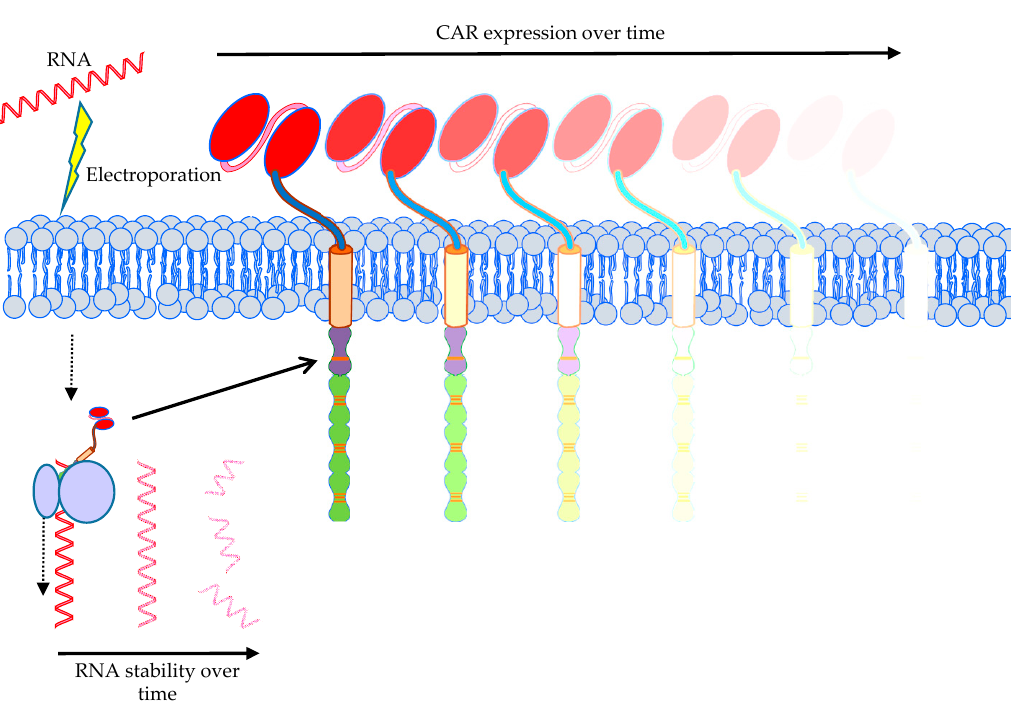
Figure 11. Schematic representation of introduction of a CAR by mRNA electroporation. Indicated are the low stability of the introduced mRNA over time and the transient expression of the CAR on the T-cell surface. The Motifolio Scientific Illustration Toolkit was used for the generation of this figure. The clinical trials published by Beatty et al. and Maus et al., using mesothelin as antigen, showed a cytokine release syndrome (CRS) in one mesothelioma patient resulting in adverse events (anaphylaxis, cardiac arrest, respiratory failure, disseminated intravenous coagulation) within minutes of completing the third infusion [223,225]. In contrast, in pancreatic cancer patients no cytokine release syndrome